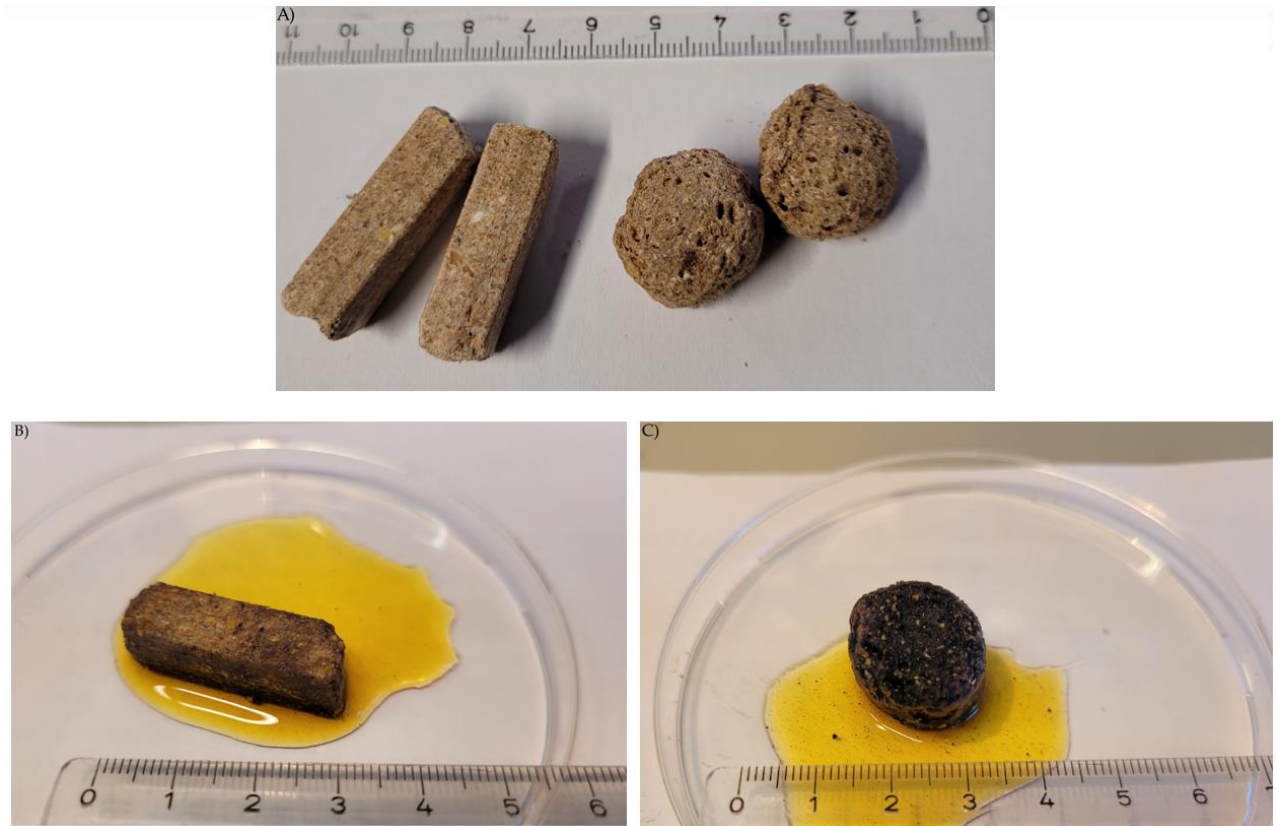
Figure 2. Diets. ( A ) Intact pellets (PEL) and extruded kibbles (EXT); ( B ) Intact pellet stained with Lugol ´ s iodine; ( C ) Intact extruded kibble stained with Lugol ´ s iodine. After centrifugation, there were blue areas in the sediment in the diet and chyme samples from the stomach, small intestine and colon (example diet: Figure 1). Caecum content was an exception, since the complete sediment was stained. The caecum content of mice fed with diet PEL was stained completely in an intensive blue. The staining was less intensive and more of a violet shade in the samples from EXT mice (Figure 3).